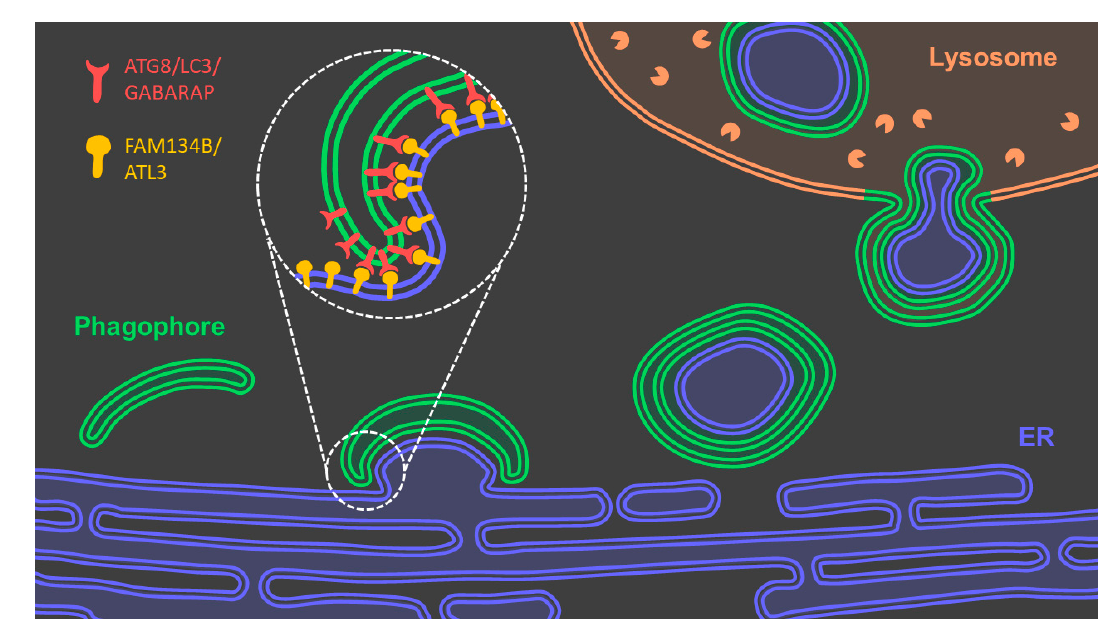
Figure 4. Schematic illustration of reticulophagy . Reticulophagy receptors FAM134B/ATL3 present in the surface of the ER-membrane are recognized by ATG8/LC3/GABARAP proteins in the surface of the phagophore. As a result of this interaction fragments of the ER are enclosed by the phagophore, forming an autophagosome, which delivers the enclosed ER fragments to the lysosome for degradation.